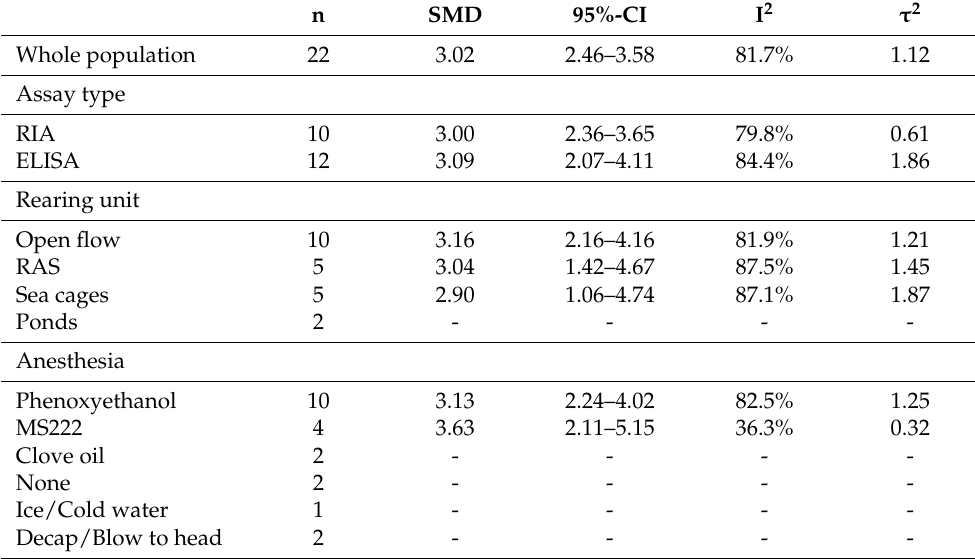
Table 5. Results of the meta-analysis regarding the standardized mean difference (SMD) be- tween basal and post-stress cortisol levels, including subgroup analysis. ES: effect size; 95%-CI: 95% confidence intervals; I 2 : Higgin’s and Thompson’s between-study heterogeneity statistic; τ 2 : heterogeneity